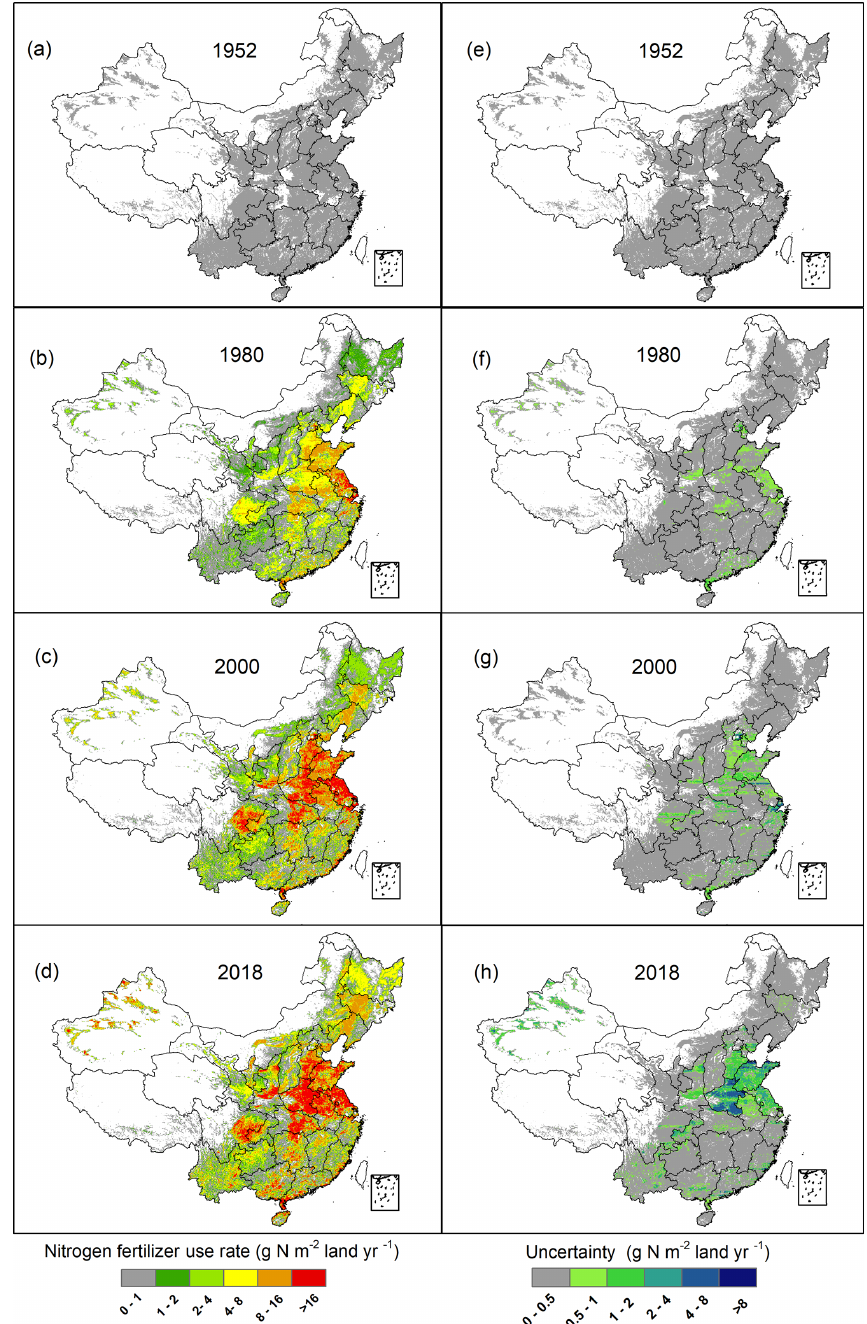
Figure 5. Spatial distribution of the rates (a–d) and the uncertainties (e–h) of nitrogen fertilizer use during different periods in China. The four panels from the top to the bottom indicate the rates (a, c) and the uncertainties (b, d) in 1952, 1980, 2000, and 2018, respectively; the value in the scale bar indicates the N fertilizer use rate per square meter of